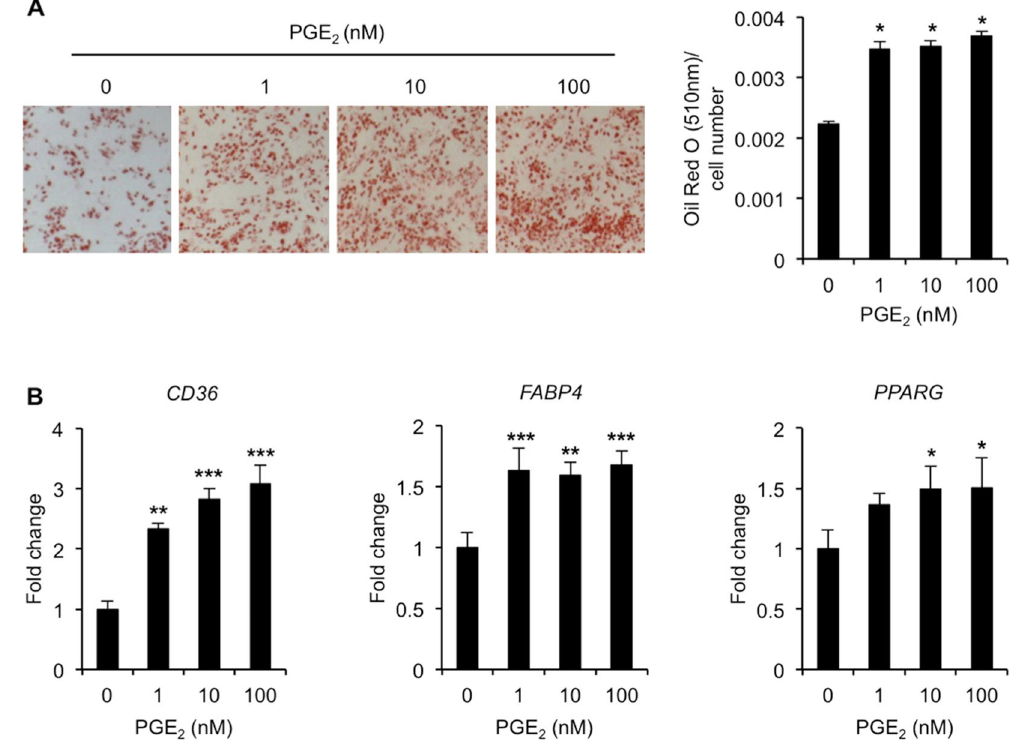
Figure 3. PGE 2 enhances hBMSC adipogenesis. ( A ) Oil Red O staining was used to assess the influence of continuous PGE 2 treatment on triglyceride accrual in hBMSC cultures at day 17 post-adipogenic induction. * p < 0.001 as compared to untreated hBMSCs using ANOVA. ( B ) RT-qPCR was used to determine expression levels of adipogenic markers PPARG , FABP4 and CD36 in hBMSCs at day 17 post-adipogenic induction. Data were normalized to GUSB and expressed as fold change as compared to non-induced controls at day 0